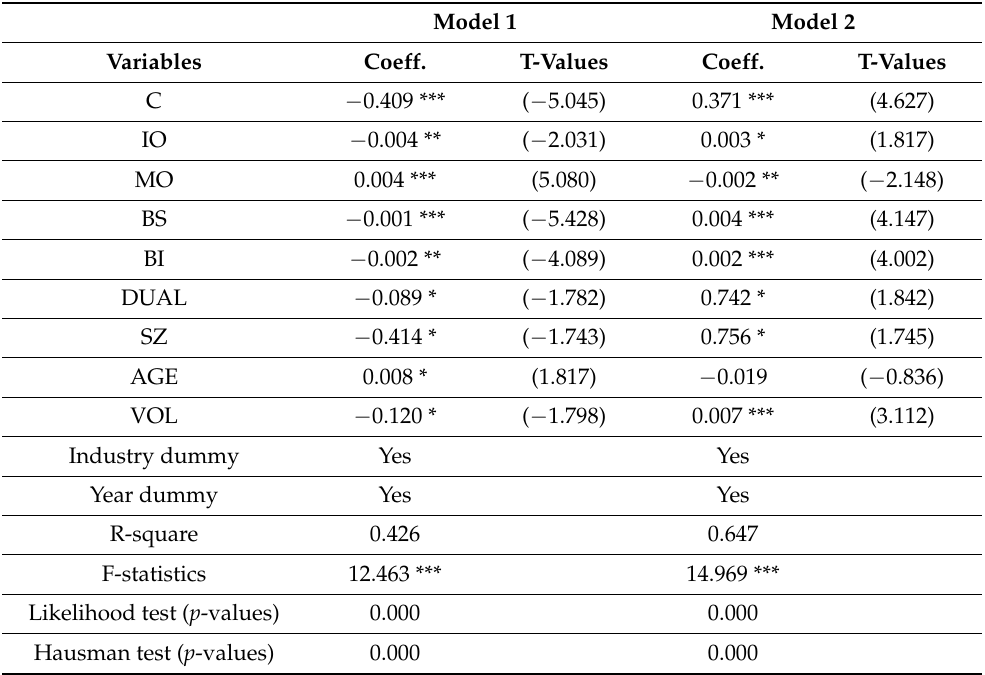
Table 4. Fixed effect